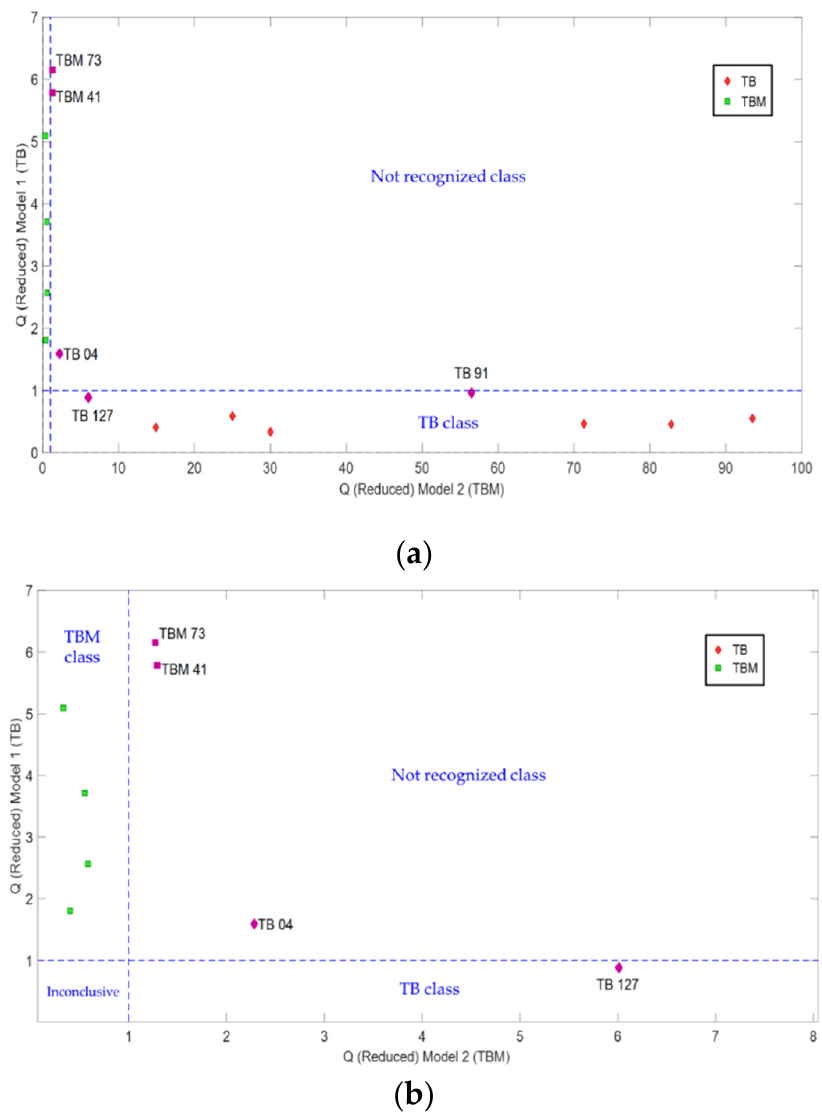
Figure 5. Coomans’ plot for soft independent modeling for class analogy (SIMCA) validation samples. ( a ) Complete Cooman’s plot and ( b ) magnified view of the bottom, left-hand part of ( a ).